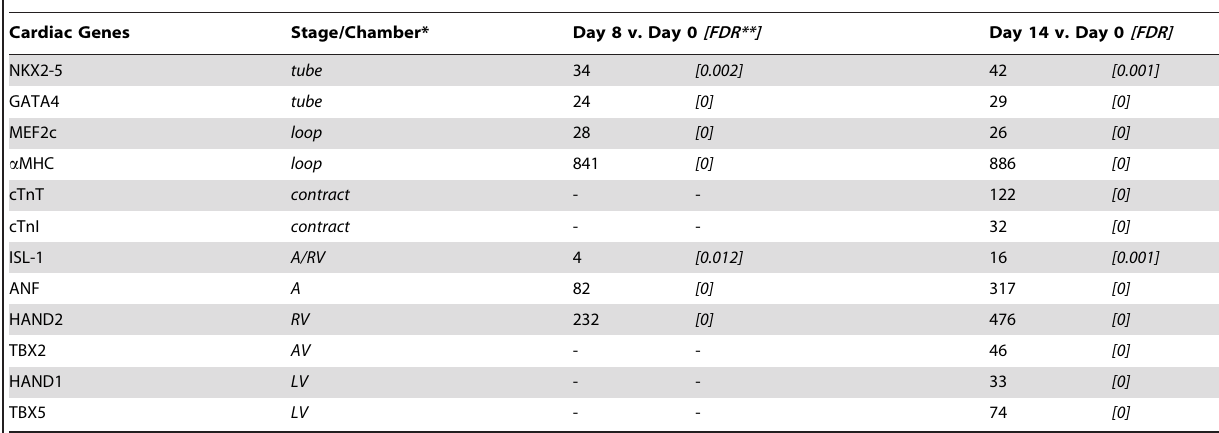
Table 1. Fold-changes in Cardiac-Specific Genes.